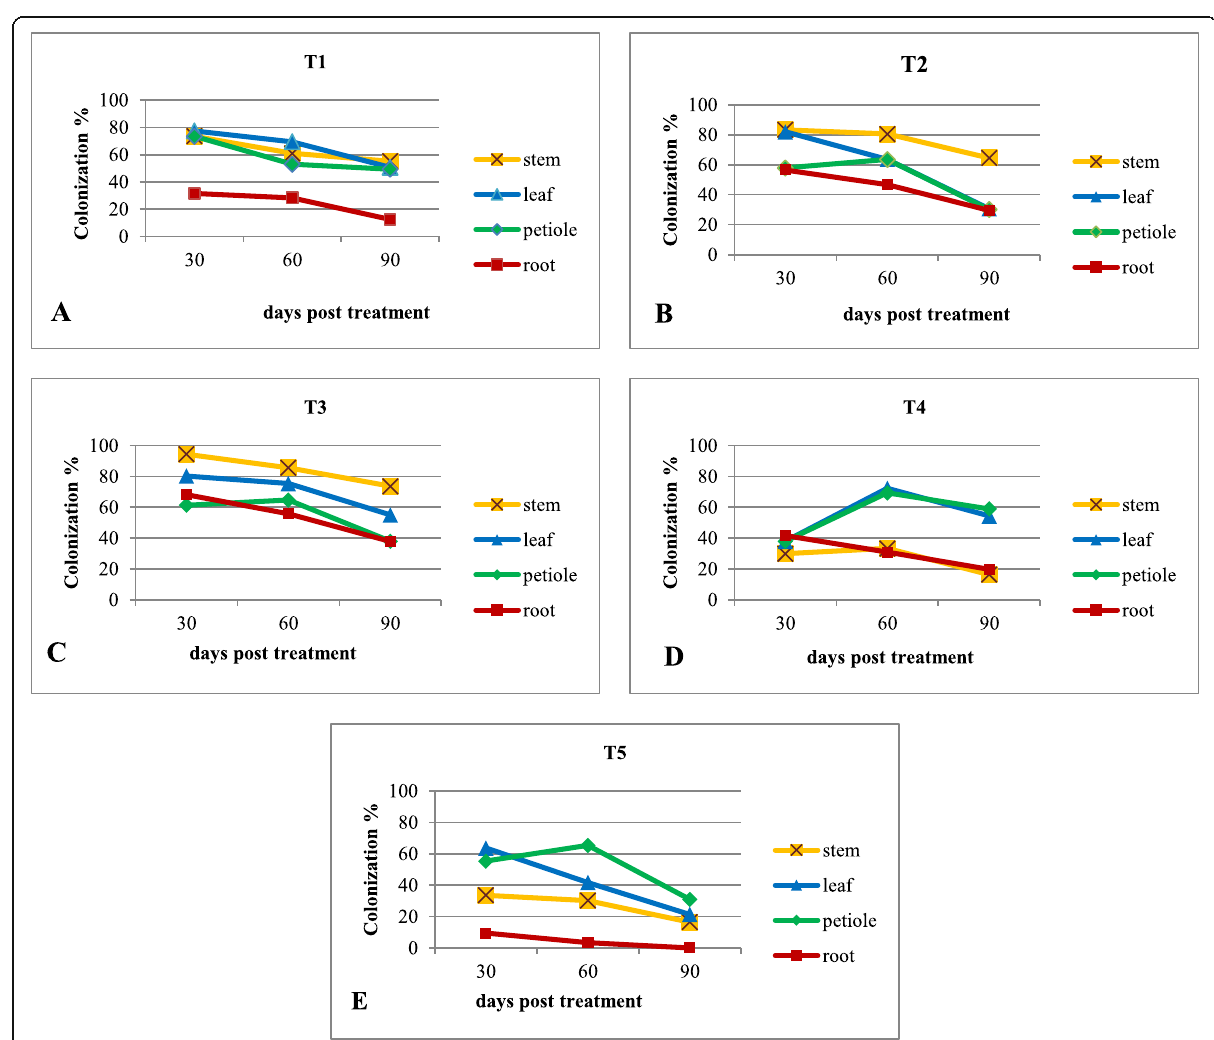
Fig. 1 Re-isolating of the fungus, Beauveria bassiana , from cucumber tissues under the laboratory conditions after different periods of treatment ( a seed dusting, b seed immersion, c soil drench, d seedling drench, e foliar